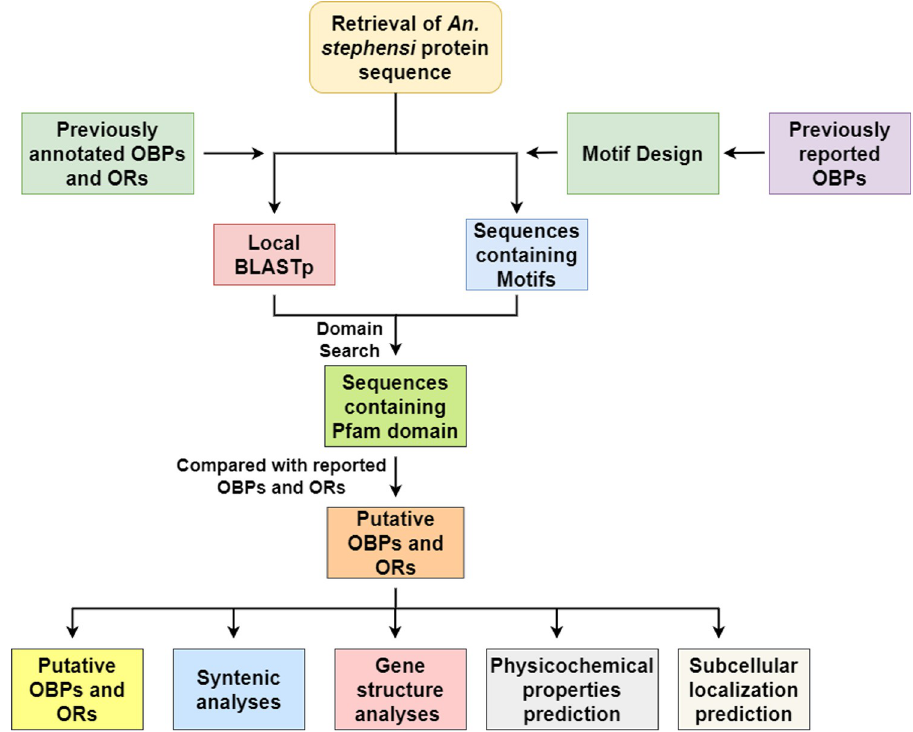
Fig 1. Pipeline of the methodology. Pipeline of the methodology used for this study is